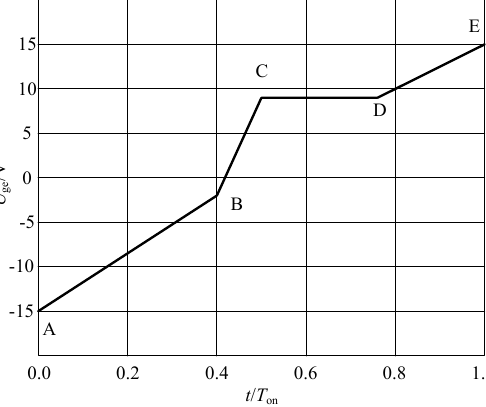
Figure 4. The gate voltage U ge changing process.